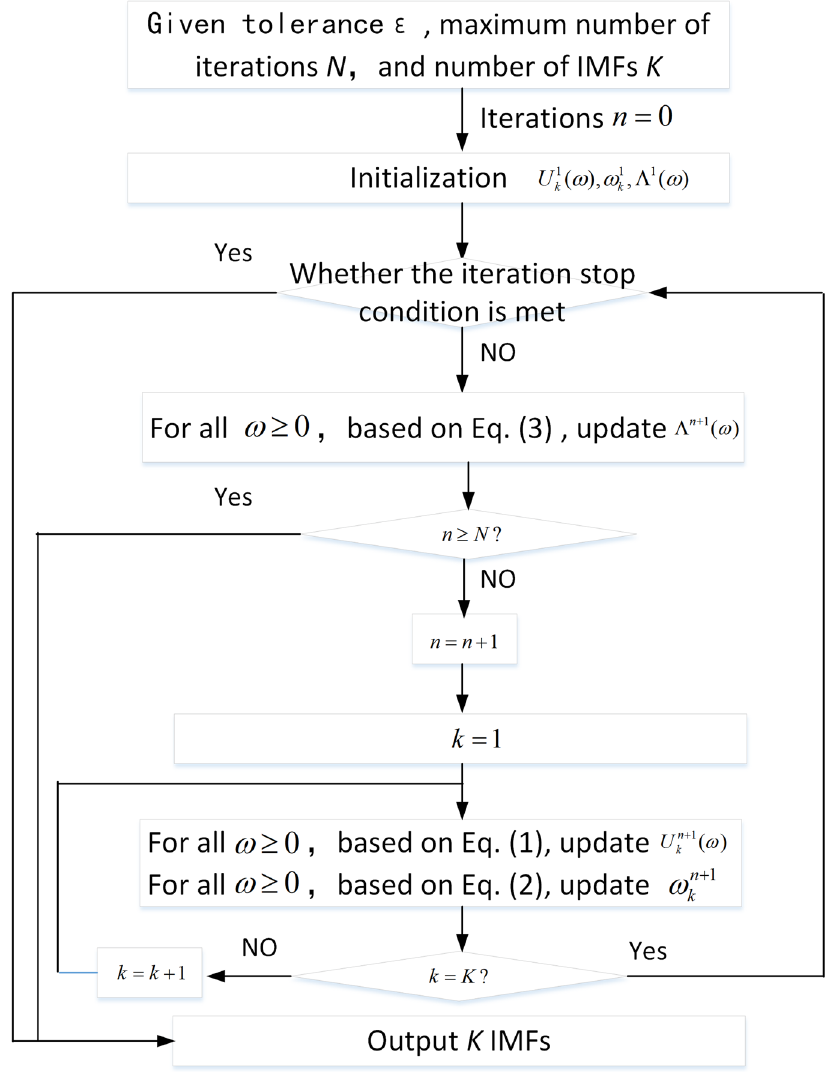
Figure 9. The flow chart of